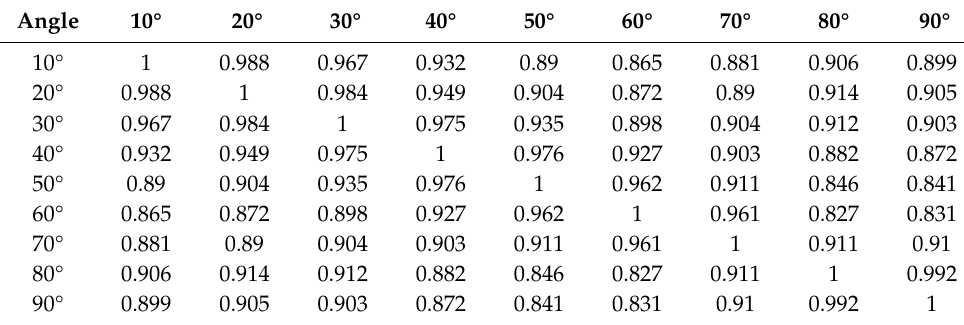
Table 2. Correlation matrix of H2 Hand.